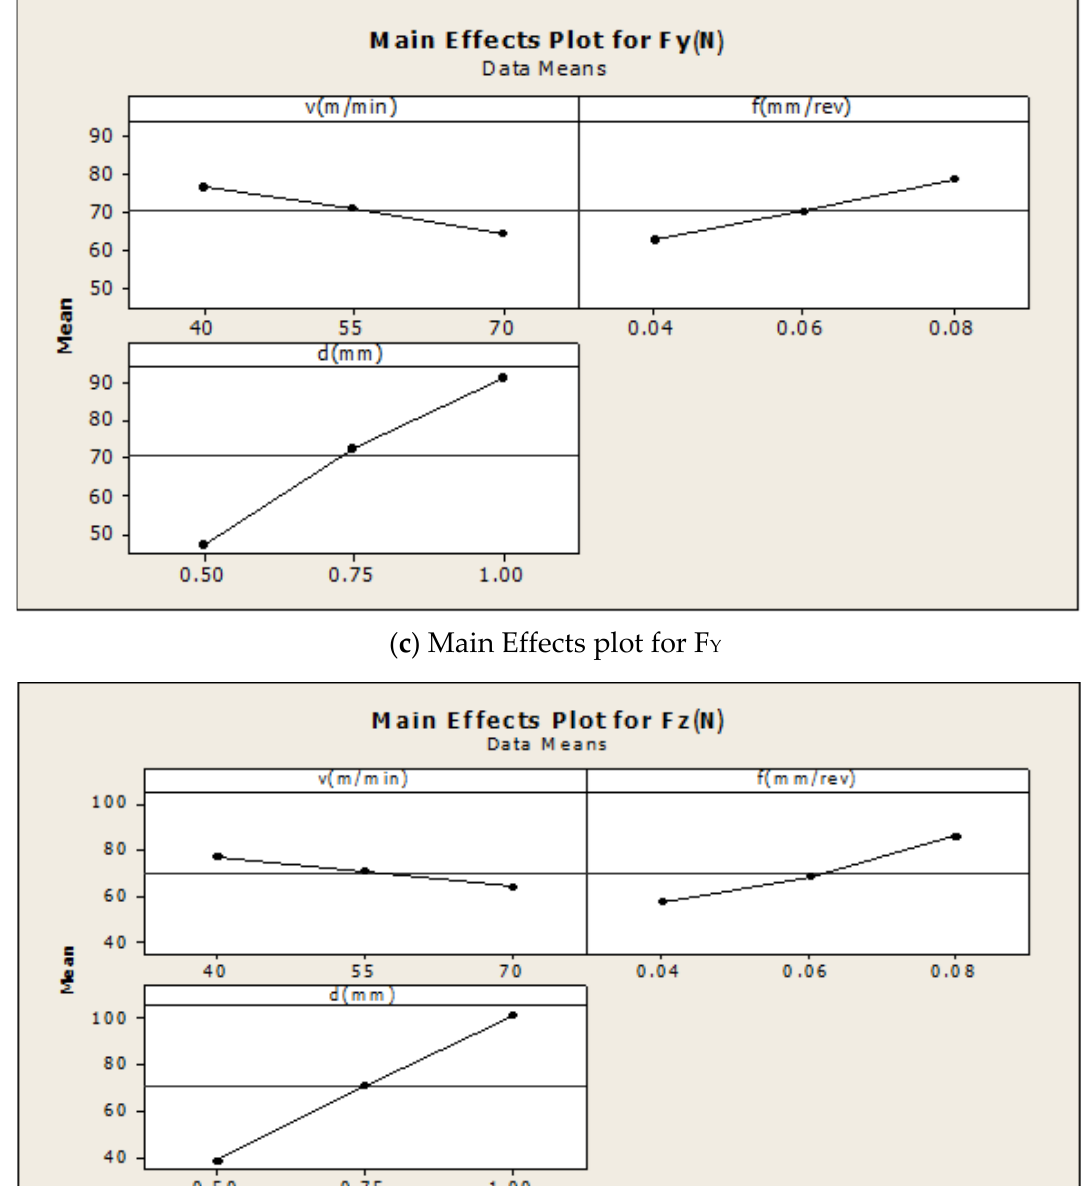
( d ) Main Effects plot for F Z Figure 2. Main Effects Plot for VB, F X , F Y and F Z . Figure 2. Main Effects Plot for VB, F X , F Y and F Z . 3.2. Contour Plot for VB, F X , F Y and F